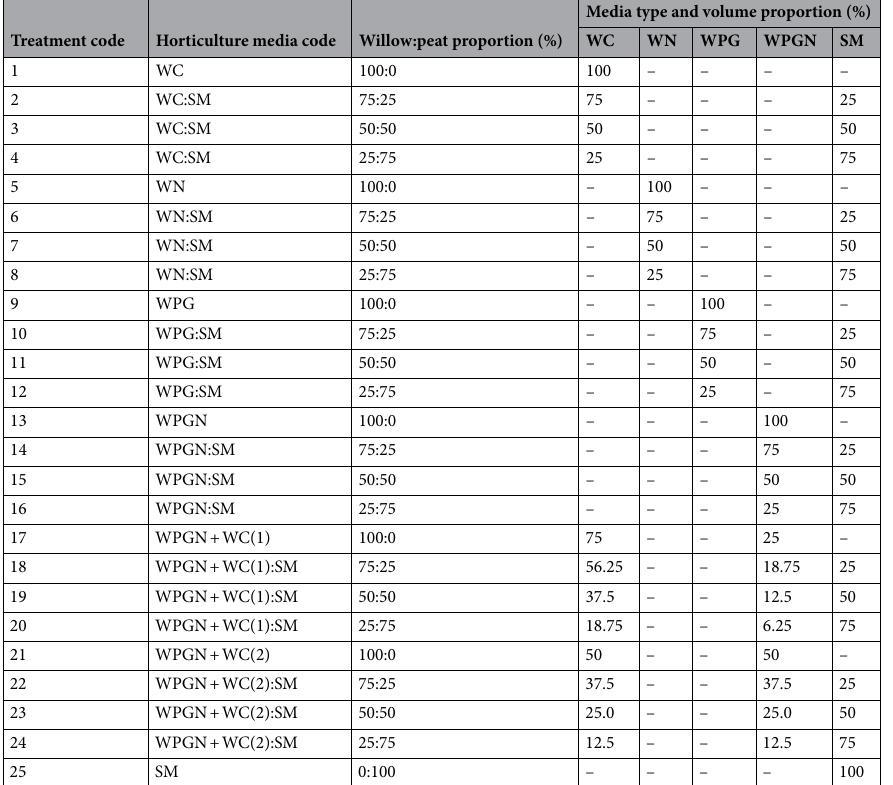
Table 1. Horticulture media mixtures in % of volume. WC, willow compost; WC:SM, willow compost + sphagnum moss substrate; WN, willow compost with mineral nitrogen; WN:SM,